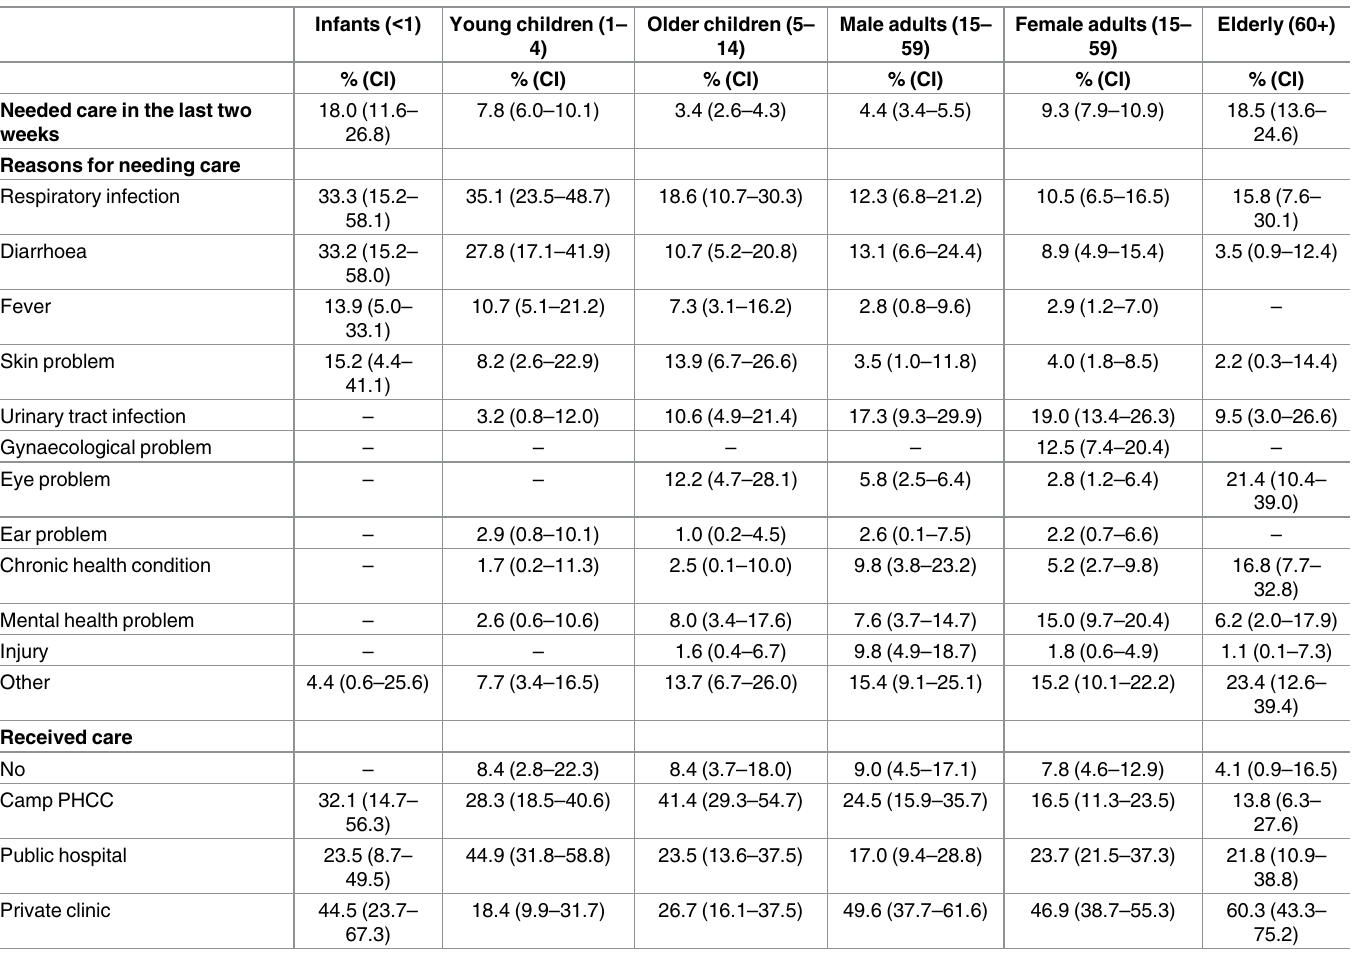
Table 2. Health needs and care seeking behaviours in the two weeks preceding the